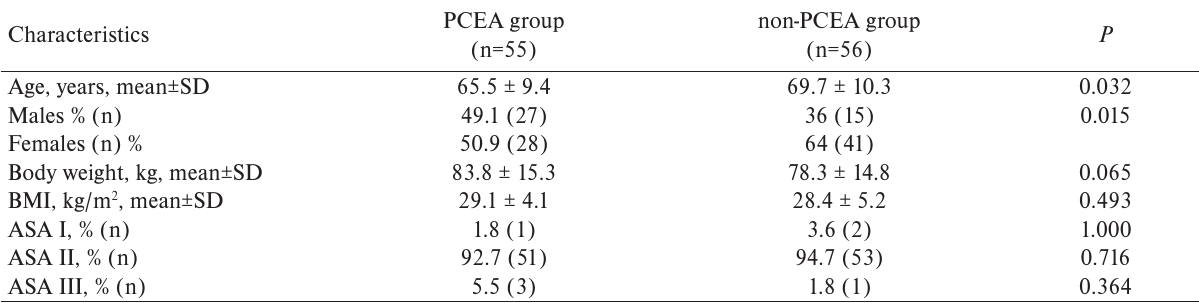
Table 2. The baseline demographic and presurgical characteristics.